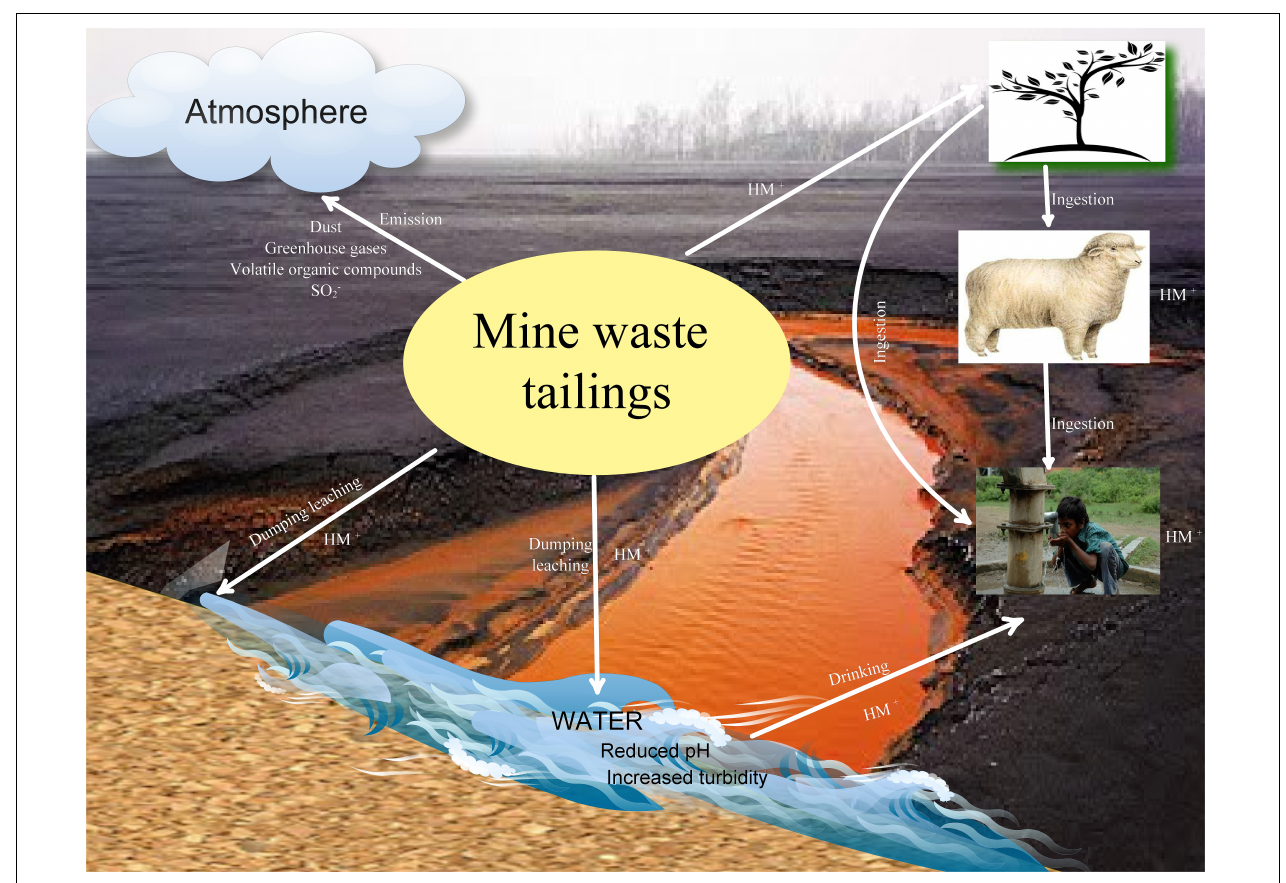
FIGURE 1 | Destruction of the ecosystem by mine